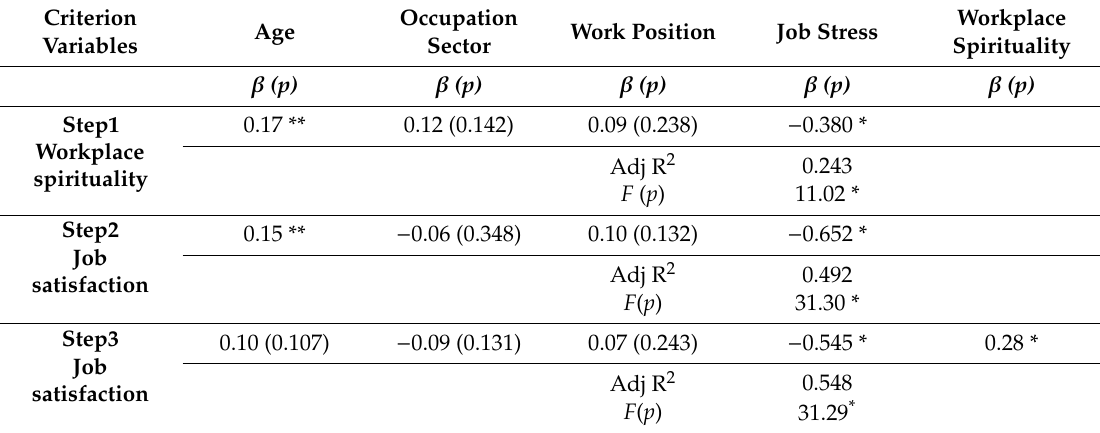
Table 4. Mediating e ff ects of workplace spirituality on job stress and job satisfaction ( N =